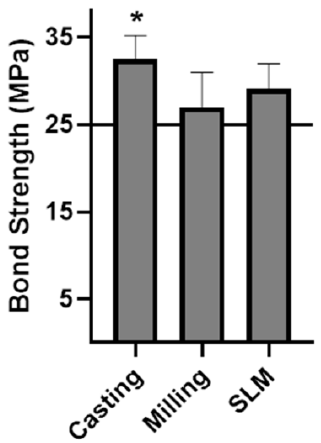
Figure 10. Metal-Ceramic bond strengths of the casting, milling, and SLM groups. The horizontal line at 25 MPa is the pass strength according to ISO 9693-1:2012. The asterisk (*) denotes results statistically significantly di ff erent compared with the other groups ( p <